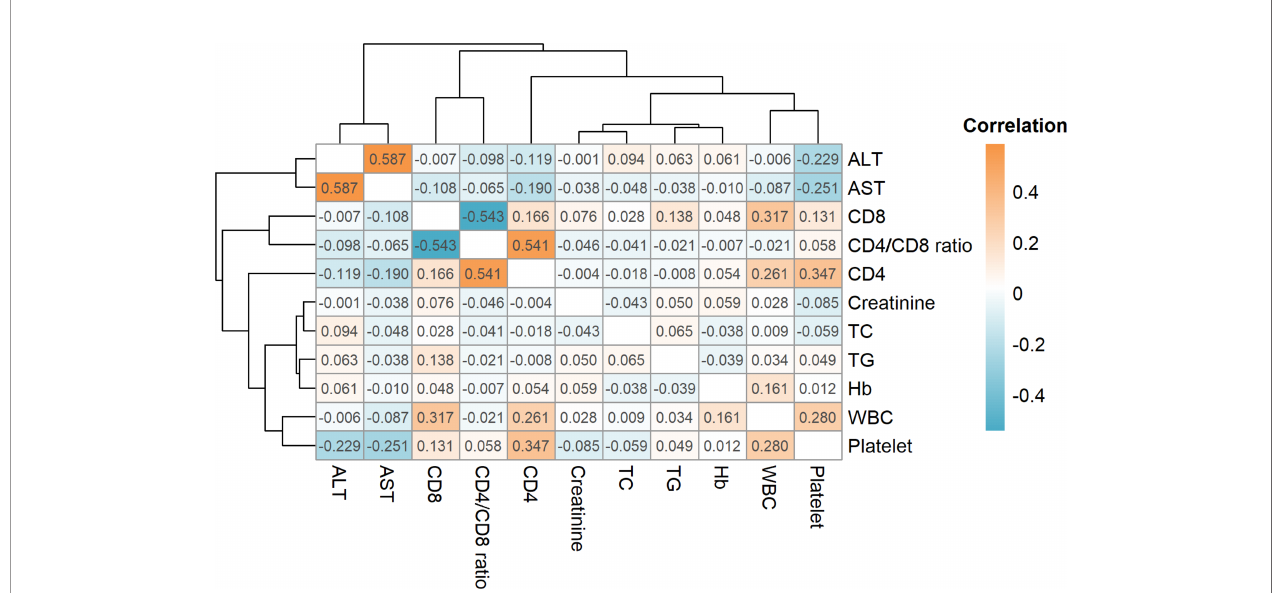
FIGURE 1 | Correlations for all clinicopathological variables. The orange color indicates a positive correlation while cyan indicates a negative correlation. ALT, alanine aminotransferase; AST, aspartate aminotransferase; CD4, CD4 + ; T cell, CD8: CD8 + T cell; TC, total cholesterol; TG, total cholesterol; Hb, total cholesterol; WBC, white blood cell.